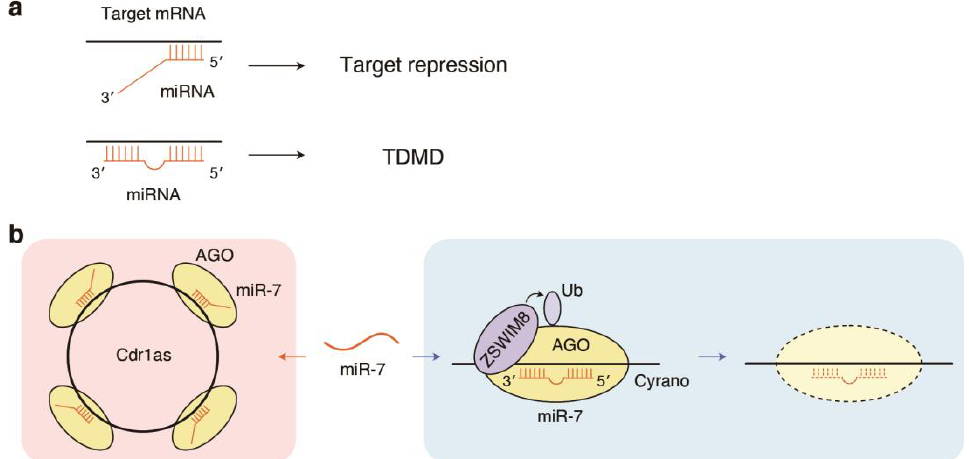
Figure 3. The miRNA decay by target-directed miRNA degradation (TDMD). ( a ) Distinct outcomes of target recognition: target repression vs. TDMD. ( b ) A long ncRNA Cyrano mediates TDMD of miR-7. ZSWIM8, an E3 ubiquitin ligase, binds to AGO2 and induces polyubiquitination and degradation of AGO2. By comparison, Cdr1as, a circular RNA with more than 70 binding sites for miR-7, interacts with miR-7 and prevents miR-7 from downregulation.